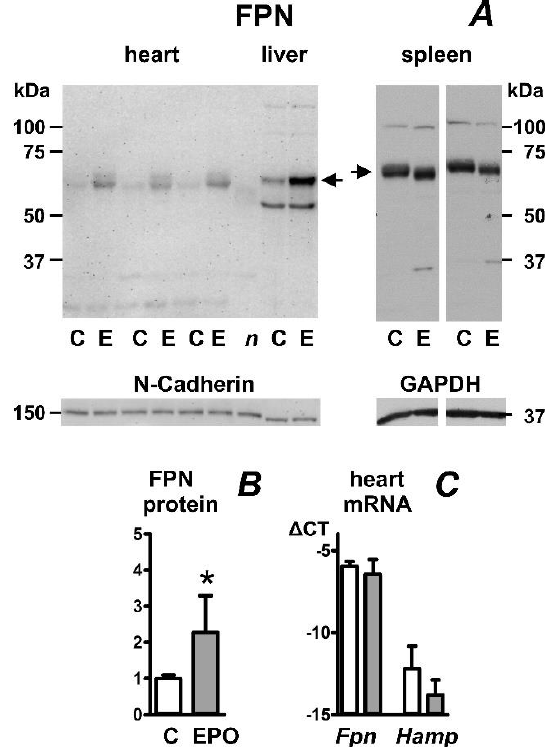
Figure 1. Effect of erythropoietin administration on ferroportin protein (FPN) content in mouse heart, liver and spleen. ( A ) Immunoblot of heart, liver, and spleen membrane protein fraction; ( B ) Quantification of heart immunoblot, n = 4; ( C ) Real-time PCR quantification of heart Fpn and Hamp mRNA expressed as Δ CT relative to Actb mRNA, n = 4. EPO was administered daily for four days at 50 U/mouse to male C57BL/6J mice; mice were sacrificed 24 h after last administration. C, samples from control mice; E, samples from EPO-treated mice. Samples were heated to 50 ◦ C prior to loading; n (negative control) represents a sample from EPO-treated mouse heart, which was heated to 85 ◦ C. N-Cadherin or GAPDH is used as loading control, arrows indicate the ferroportin-specific bands. Asterisk denotes statistical significance ( p <